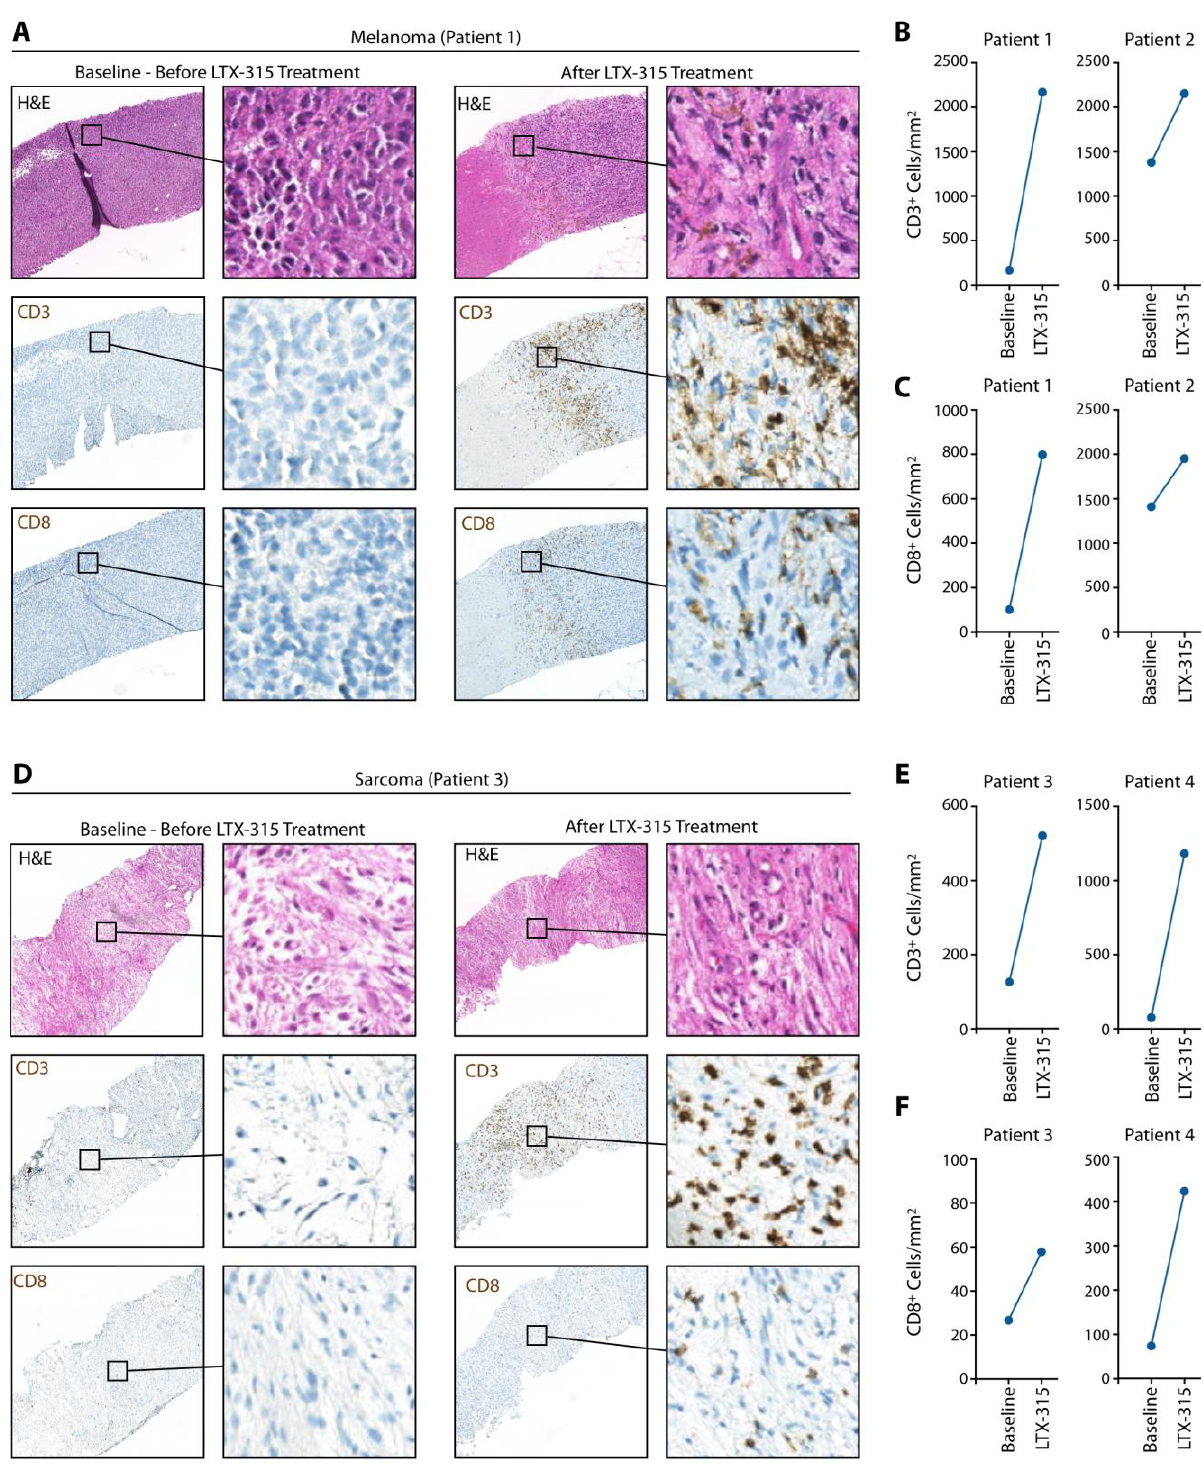
FIGURE 4: LTX-315 treatment causes CD8 T cell infiltration of melanoma and soft tissue sarcoma tumors in patients. (A) Representative hematoxylin and eosin (H&E) staining and immunohistochemistry for CD3 + and CD8 + cells (brown) on melanoma patient biopsy sections before and after LTX-315 treatment. (B) Quantification of CD3 + cells in melanoma biopsies, based on immunohistochemistry staining shown in (A). (C) Same analysis as shown in (B) for quantification of CD8 + cells. (D) Representative H&E staining and immunohistochemistry for CD3 + and CD8 + cells (brown) on patient biopsy sections of sarcomas before and after LTX-315 treatment. (E) Quantification of CD3 + cells in sarcoma biopsies, based on immunohistochemistry staining shown in (D). (F) Same analysis as shown in (E) for quantification of CD8 +